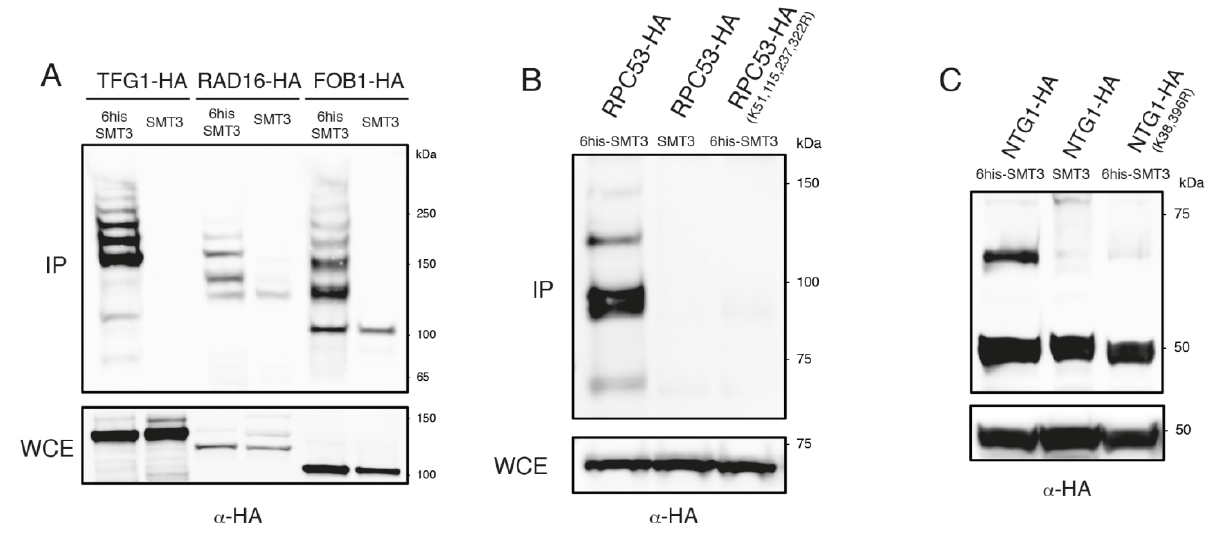
FIGURE 3: Mutational analysis of SUMO sites identified. (A) Histidine pulldowns from cells carrying TFG1 , RAD16 and FOB1 tagged with 3 HA epitopes in strains expressing SMT3 tagged with 6 histidines ( 6his-SMT3 ) or wild-type SMT3 (untagged control). Western blot analysis using α-HA antibodies in the pulldown demonstrates the presence of SUMO conjugates for TFG1 , RAD16 and FOB1 . (B) Histidine pulldowns from cells carrying RPC53 or RPC53 (K38,115,237,322R) tagged with 3 HA epitopes. The analysis demonstrates that lysines 38, 115, 237 and 322 (identified in our screen) are sites for the conjugation of SMT3 in RPC53 . (C) Histidine pulldowns from cells carrying NTG1 or NTG1 (K38, 396R) tagged with 3HA epitopes. The analysis demonstrates that lysines 38 and 396 (identified in our screen) are sites for the conjugation of SMT3 in NTG1